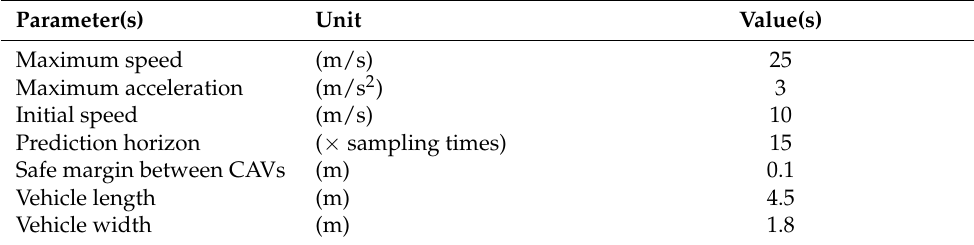
Table 1. Main parameters of the proposed algorithms and their